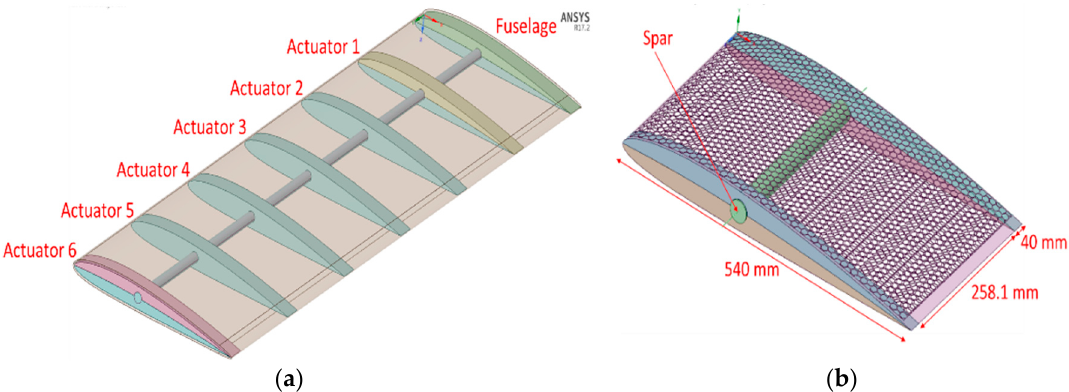
Figure 3. Computational wing model: ( a ) actuators 1–6 shows the external layer of skin and the position of morphable ribs; ( b ) one section shows the internal layer of skin and the fixed spar location.